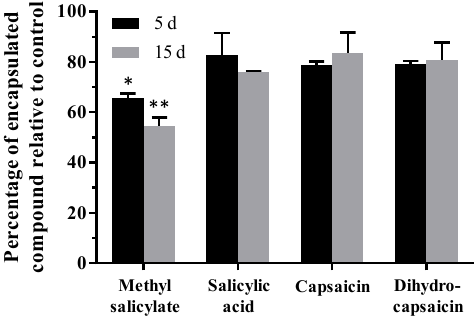
Figure 2. Stability of the loaded compounds over time. The graph indicates the percentage of compound that remained encapsulated in the nanofibers 5 and 15 days (d) after they were produced. Compound content was determined by GC-MS. Values are relative to the content measured right after the production of the nanofibers. Statistical analysis comprised multiple t test corrected for multiple comparisons by using the Holm–Sidak method. Significant changes in the content of each compound over time with respect to the corresponding initial values are indicated as: *, p < 0.05 and **, p < 0.01.